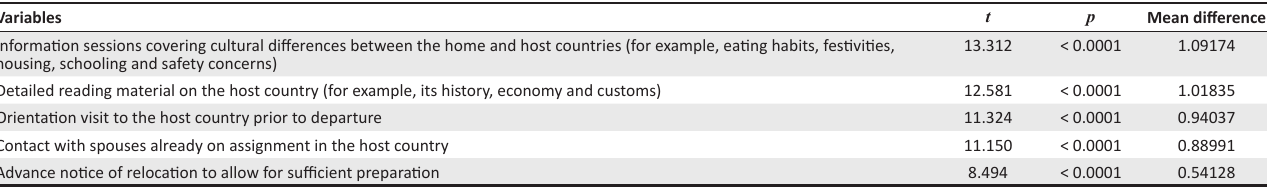
TABLE 4: Individual t -test results for preparation required versus preparation provided.